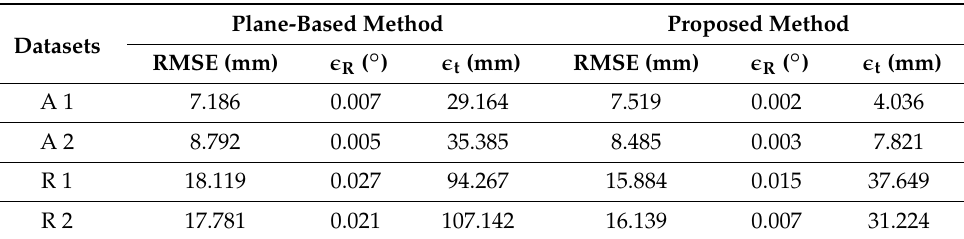
Table 1. Details of simulated datasets.